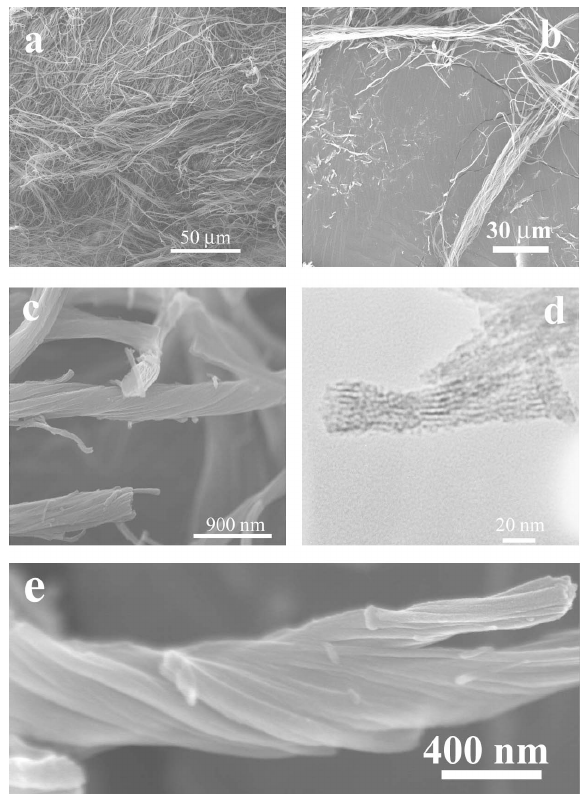
Figure 2. ( a – c ) Field-emission scanning electron microscopy (FESEM) and ( d ) transmission electron